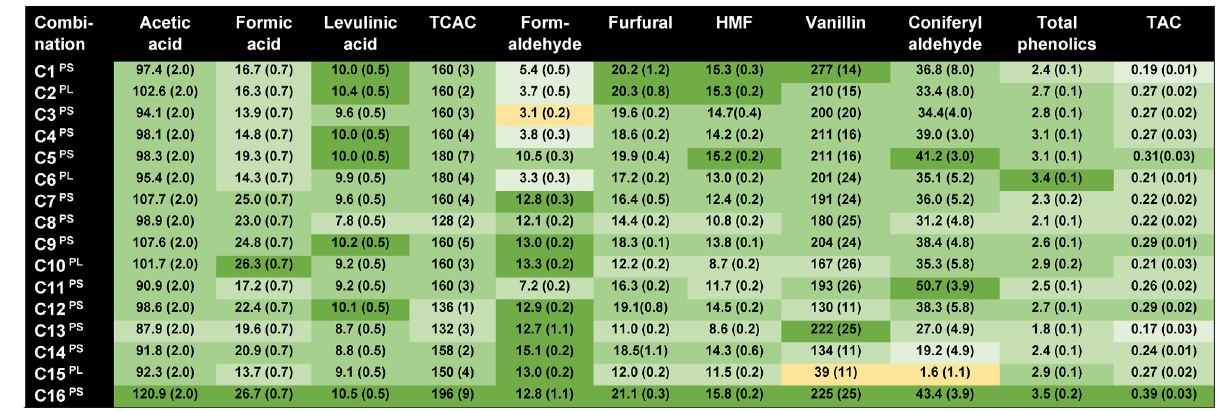
( Table 5 ). Effects on aliphatic acids and TCAC were generally small. Treatments with activated charcoal, particularly using high dosage (2.5%), resulted in comparatively large reductions of the concentrations of acids. The sulfur oxyanions, sul fi te and dithionite, caused decreases in the concentration of formic acid that exceeded 25%.